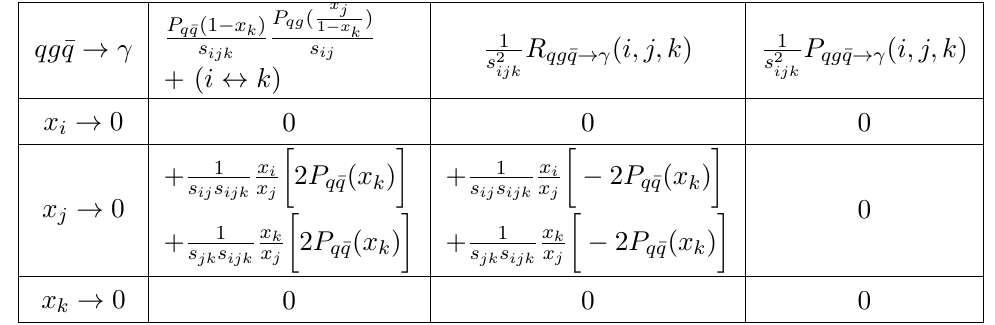
Table 5 . Singular behaviour of the P qg ¯ q → γ triple collinear splitting function in the limit where individual momentum fractions are